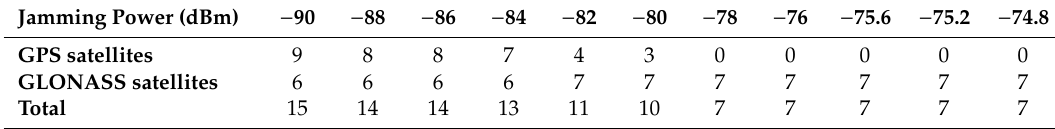
Table 7. Minimum number of available satellites for scenario #5.